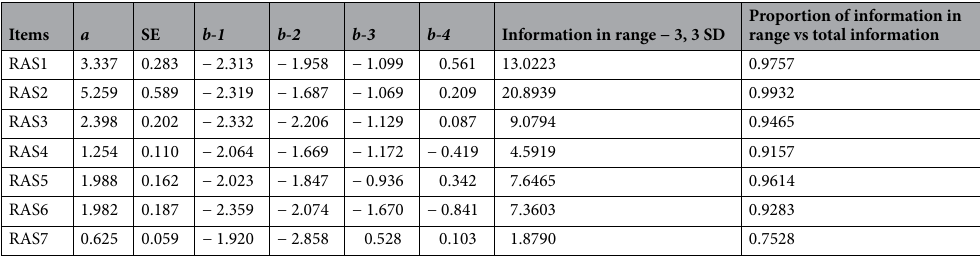
Table 5. Item Difficulty Location and Thresholds For Informational Curves for the Polish RAS. n = 733; a = discrimination parameter estimates in the RAS; b -1 = difficulty parameter estimates between response categories 0 and 1; b -2 = difficulty parameter estimates between response categories 1 and 2; b -3 = difficulty parameter estimates between response categories 2 and 3; b -4 = difficulty parameter estimates between response categories 3 and 4. Area under curve with range [− 3, 3] SD raw and percent, compared to total result of information